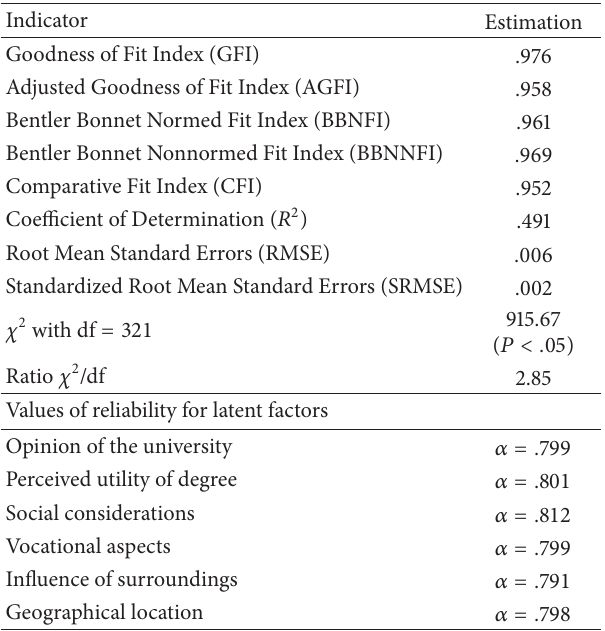
Table 3: Overall setting for structural model only for UPV engi- neering students, with an indication of reliability (estimation of 𝛼 of